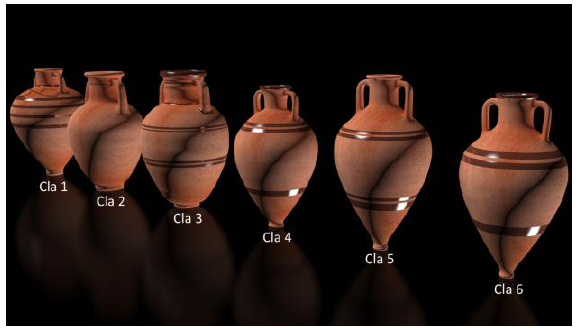
Figure 5. A group of Clazomenian amphoras from 650-600 BC.